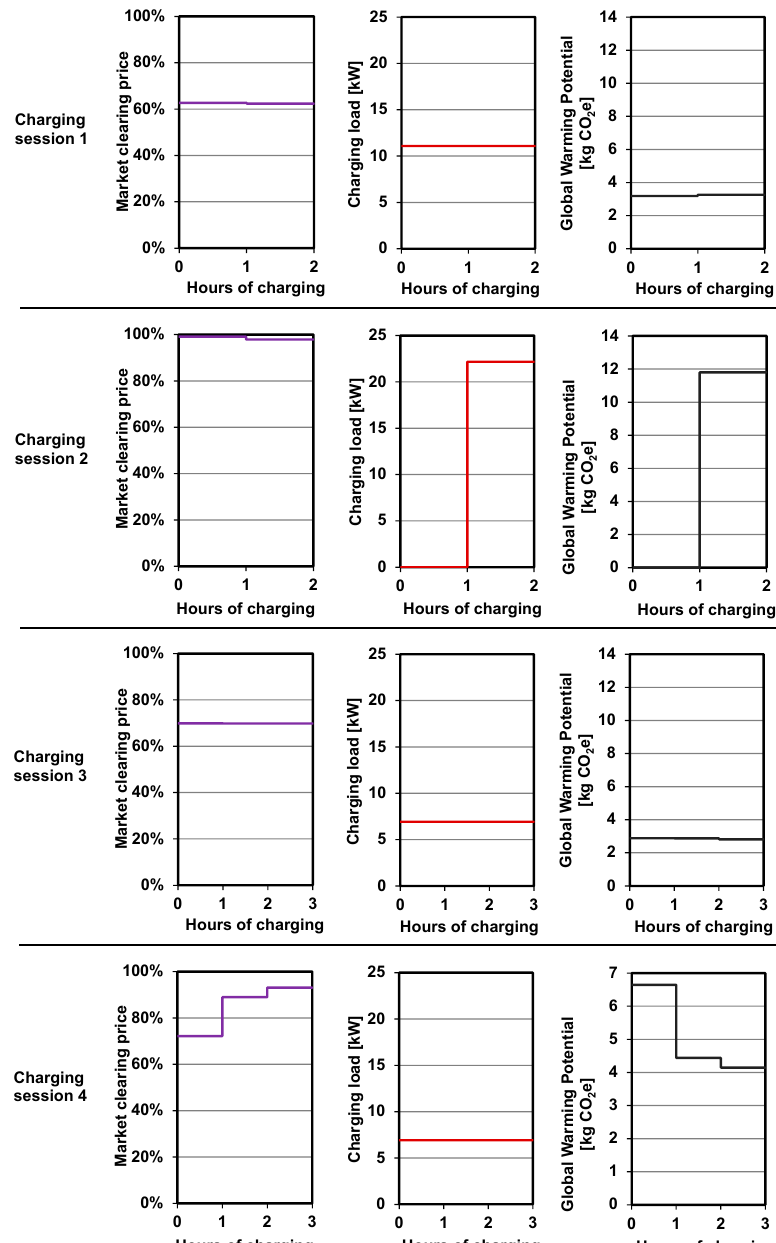
Figure 5. Profiles of market clearing price, charging load, and GWPs during the exemplary charging sessions.